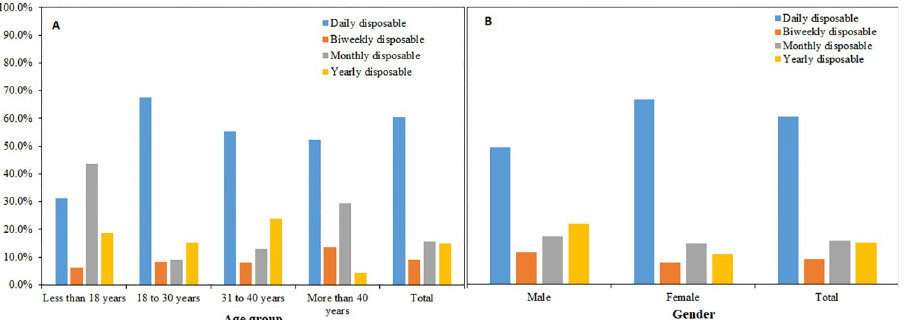
Fig 2. Distribution of purpose of contact lens materials by: (A) age group and (B), gender of